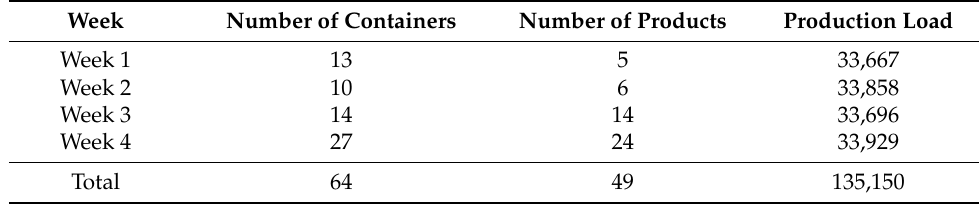
Table 3. Summary of the result for Case 3.